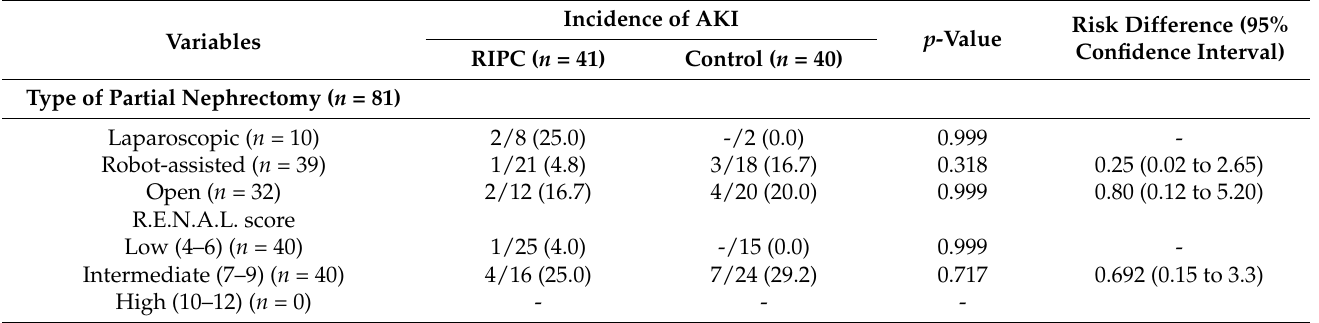
Table 5. Comparison of the incidence of acute kidney injury (AKI) between the RIPC and control groups according to the surgical modalities and R.E.N.A.L.